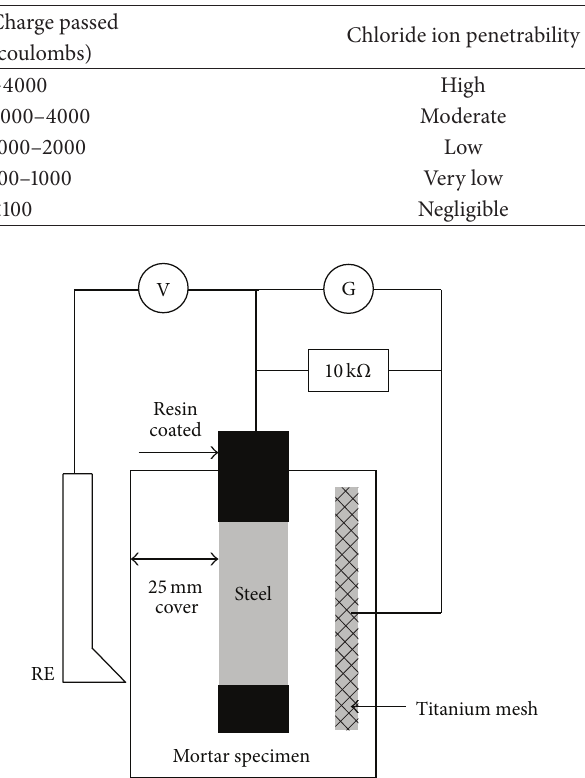
Table 3: Chloride ion penetrability based on charge passed for concrete specimen [9].